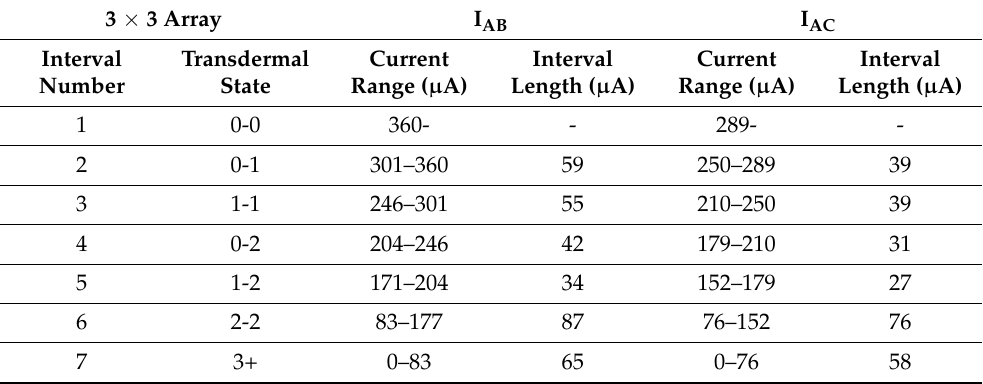
Table 1. The current interval division of the transdermal state of the 3 × 3 microneedle array model. 3 × 3 Array I AB I AC